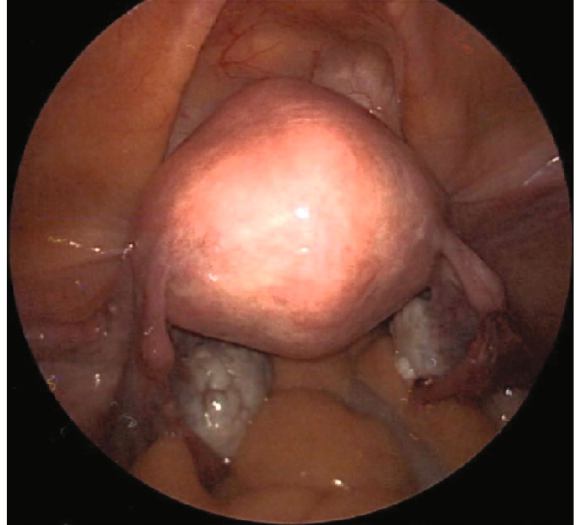
Figure 4: Pelvic anatomy at the time of hysterectomy, bilateral salpingectomy. Minimal adhesions noted and uterus did not appear